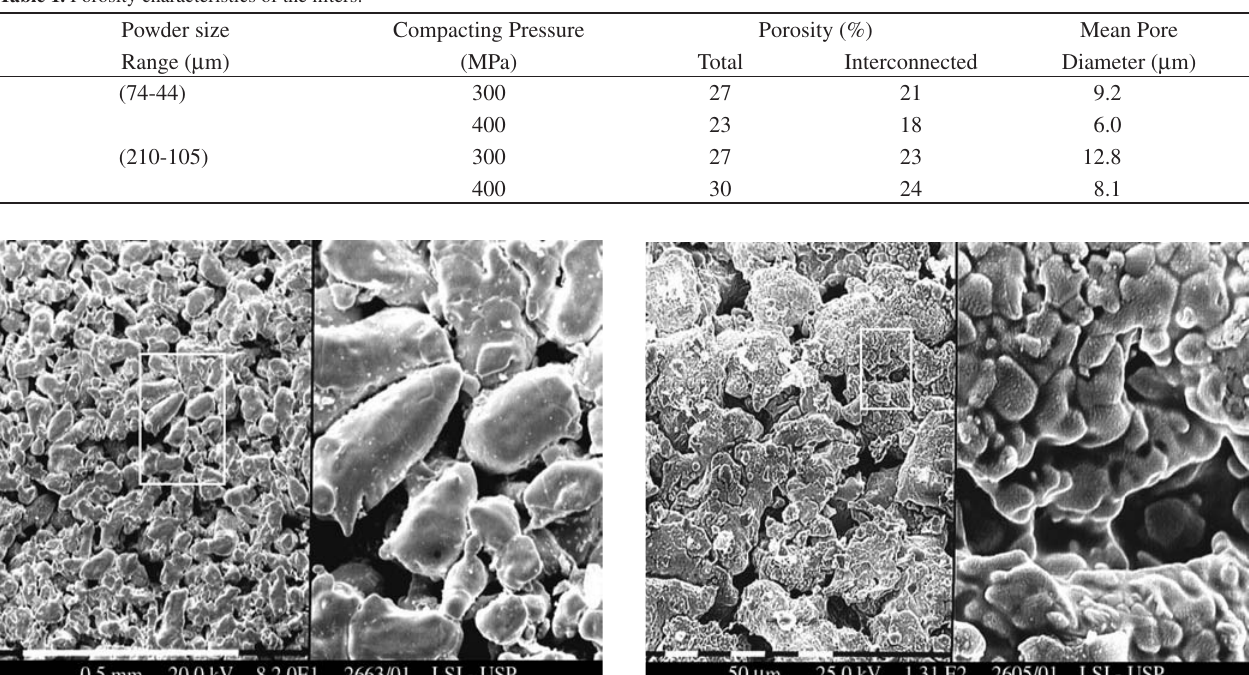
Figure 1. Filters before the corrosion test: a) produced with powders in the size range 74-44 (cid:77) m; b) produced with powders in the size range 210-105 (cid:77) m. Both filters were compacted at 300 MPa.